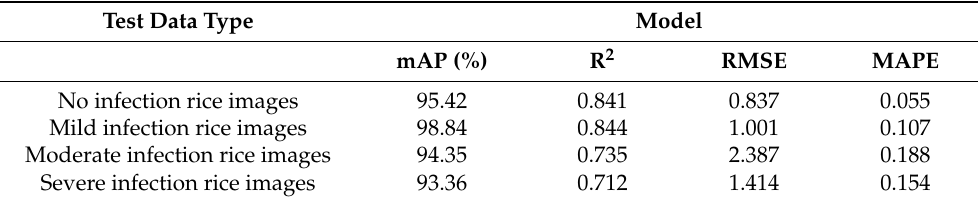
Figure 11. The model test results for no infection rice images set ( a ); mild infection ( b ); moderate infection ( c ); and severe infection ( d ). Table 4. The analysis results of the